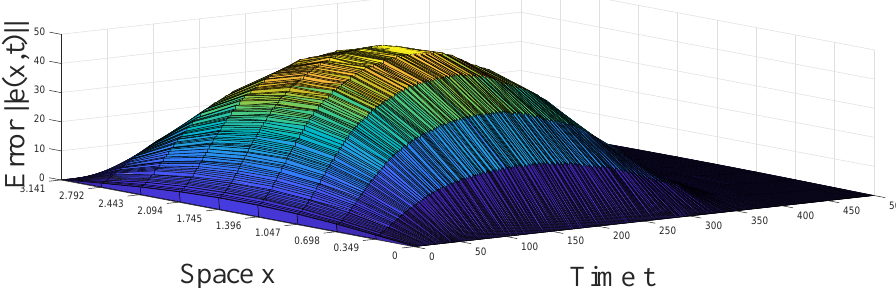
Figure 2. Spatiotemporal evolution of the error norm (cid:107) e ( x , t ) (cid:107) between systems (2) and (3) with controller (36).